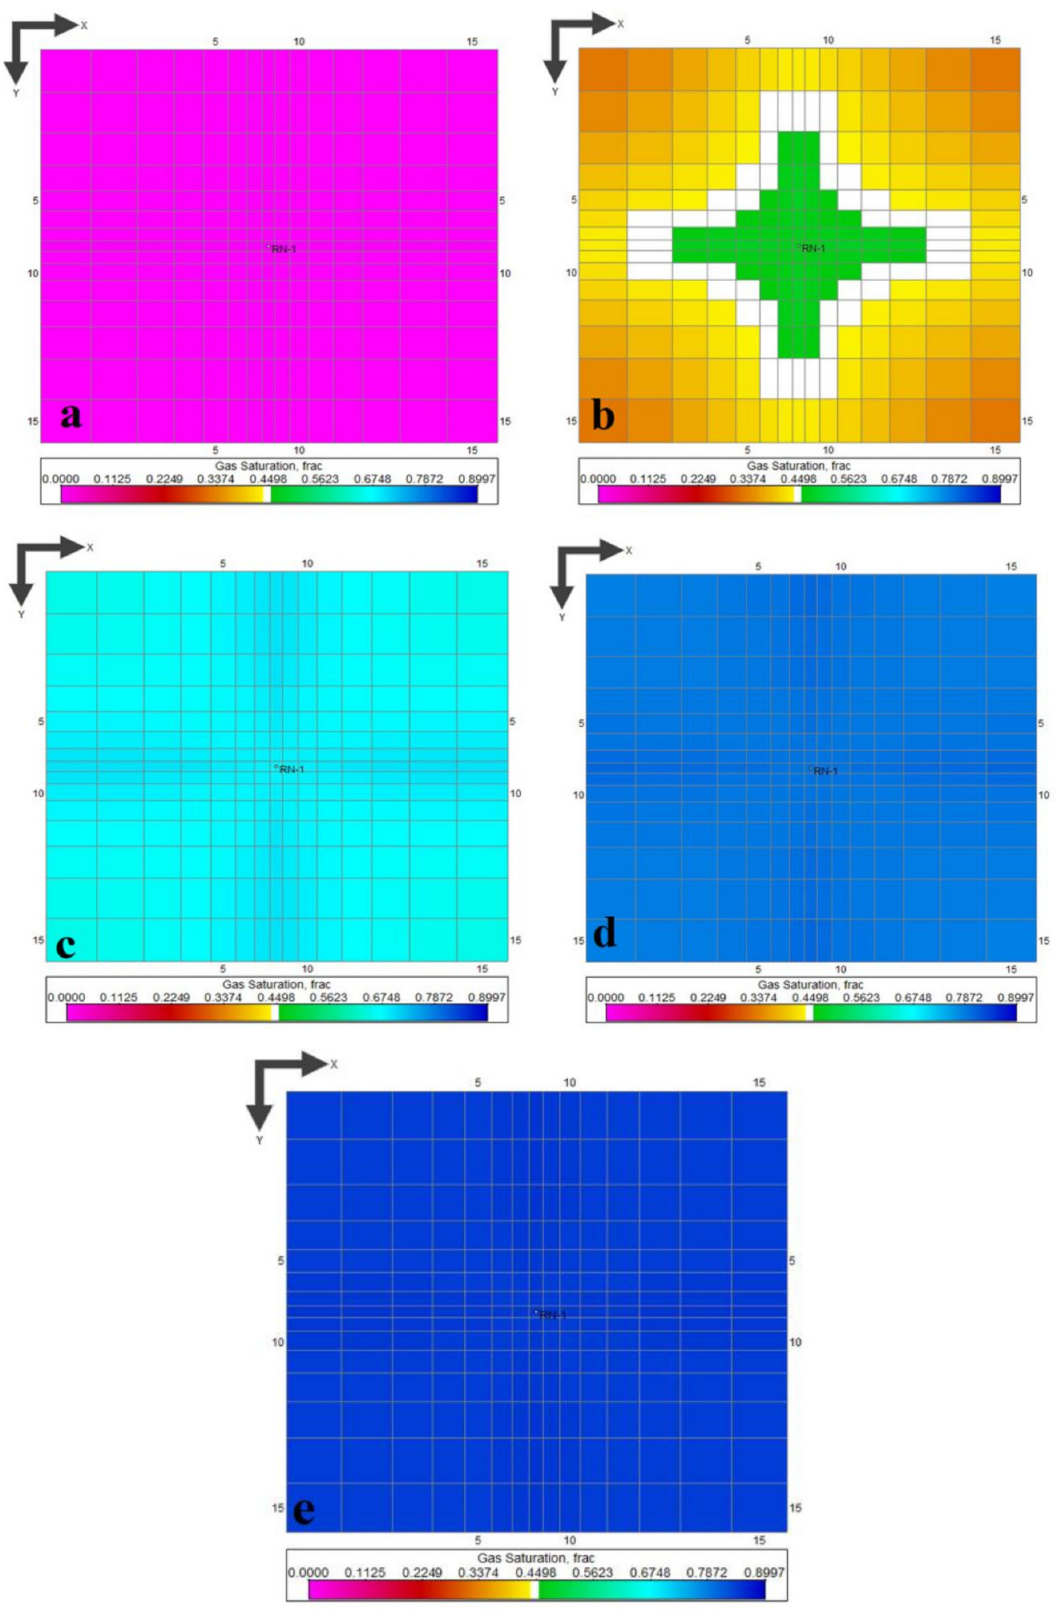
Figure 5. ( a – e ). Fracture gas saturation in the area over a period of 0 days, 1000 days, 2000 days, 3000 days and 4000 days,